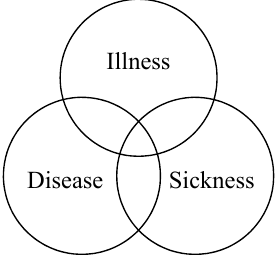
Figure 1. The model of the relationship between the different perspectives [27].